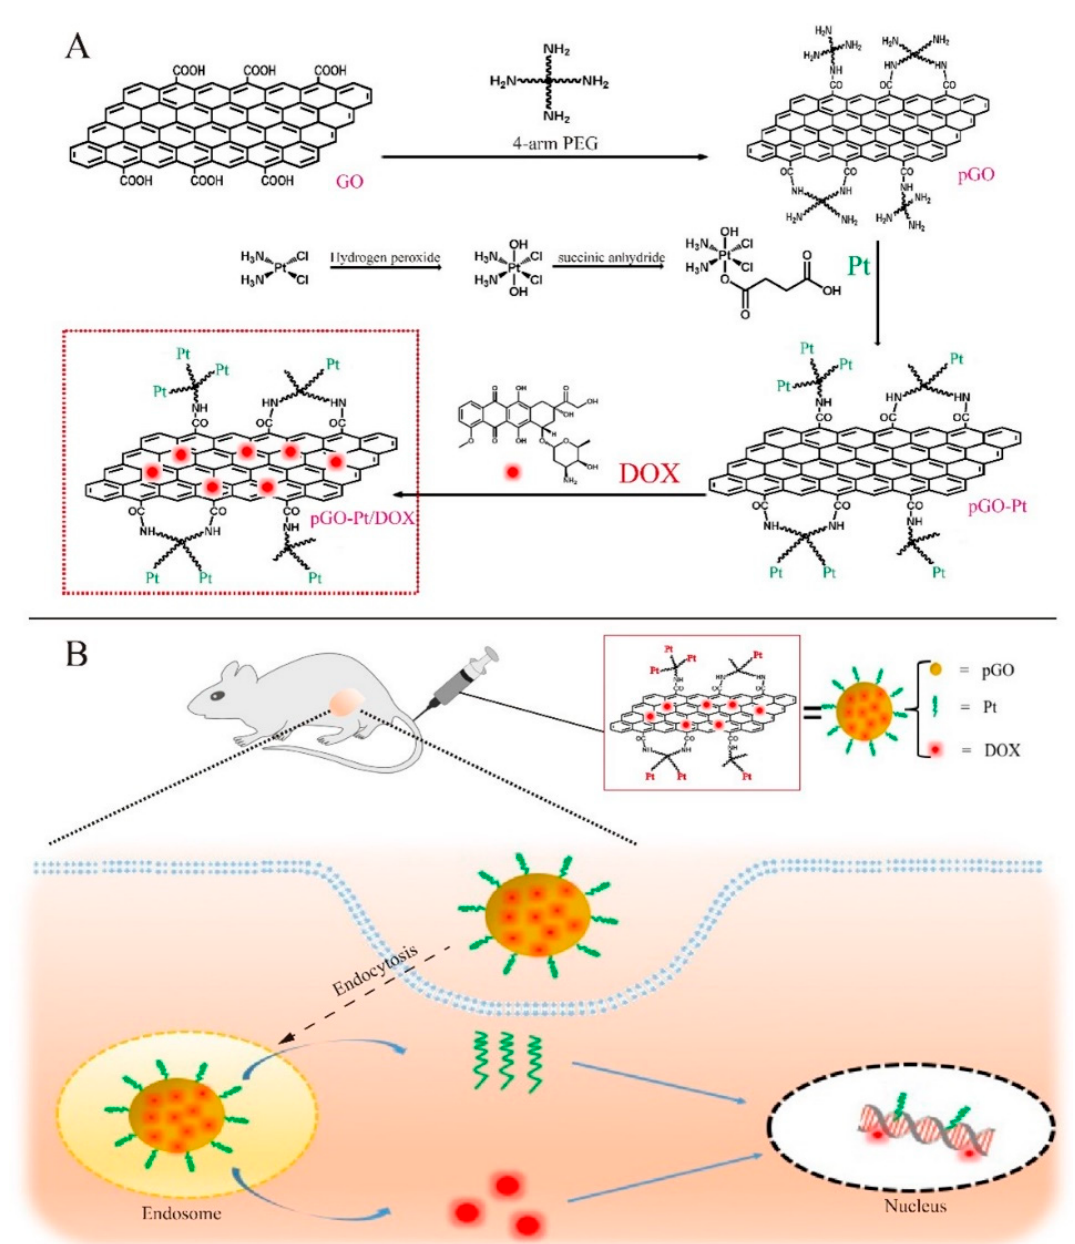
Figure 5. Illustration of synchronized codelivery of cisplatin (Pt) and doxorubicin (DOX) by Figure5. Illustrationofsynchronizedcodeliveryofcisplatin(Pt)anddoxorubicin(DOX)bypolyethylene polyethylene glycol-modified GO (PEGylated GO or pGO). ( A ) Steps in the synthesis of the glycol-modified GO (PEGylated GO or pGO). ( A ) Steps in the synthesis of the Pt-pGO-DOX dual-drug Pt-pGO-DOX dual-drug delivery system, where covalent functionalization of GO with PEG created delivery system, where covalent functionalization of GO with PEG created pGO, followed by covalent pGO, followed by covalent and noncovalent functionalization with Pt and DOX, respectively. ( B ) andnoncovalentfunctionalizationwithPtandDOX,respectively. ( B )Schematicshowingthemechanism Schematic showing the mechanism of action of tumor targeting by the Pt-pGO-DOX drug delivery ofactionoftumortargetingbythePt-pGO-DOXdrugdeliverysystem, inwhichPtgeneratesDNAlesions system, in which Pt generates DNA lesions and DOX inhibits DNA replication. (Reproduced with and DOX inhibits DNA replication. (Reproduced with permission from [45]. Copyright 2020, Nature). permission from [45] . Copyright 2020, Nature). Zhang et al. described a system for targeted drug delivery using GO and FA ligands